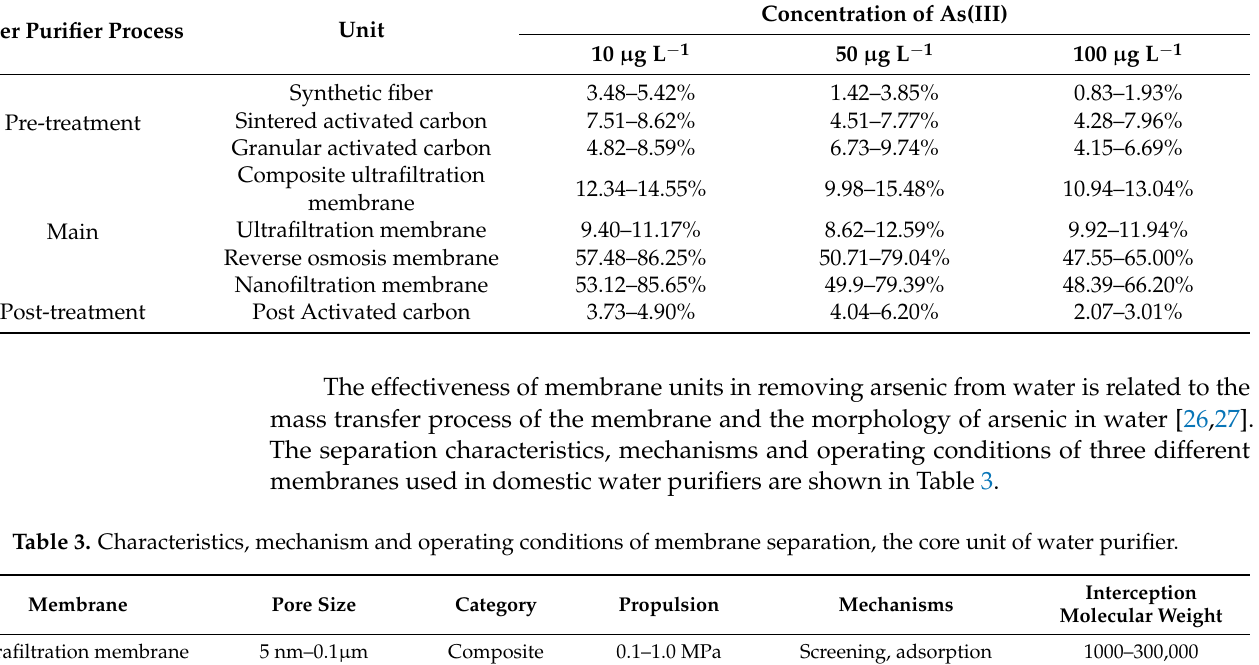
Table 2. Removal effect of each unit of water purifier for different concentrations of As(III). Water Purifier Process